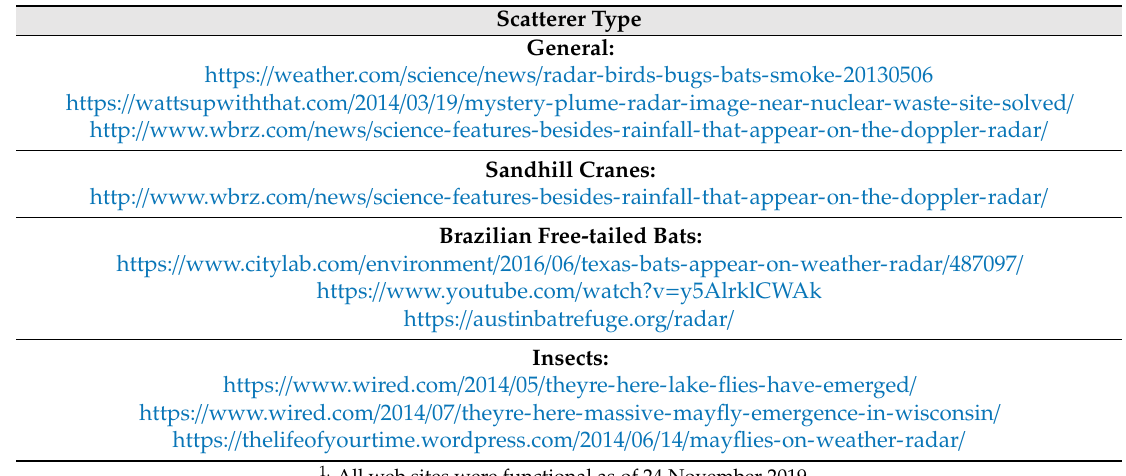
Table A1. Internet websites documenting WSR-88D detection of known biological scatterers that informed training / test data selection 1